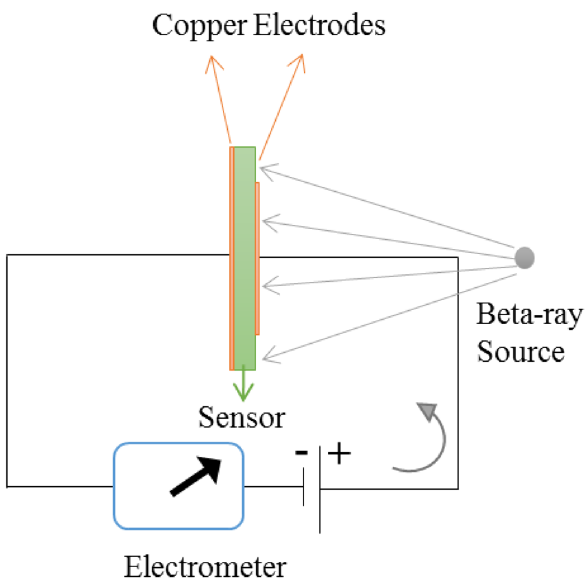
Figure 2. Electric circuit designed for sensing the beta-rays using the PC–Bi 2 O 3